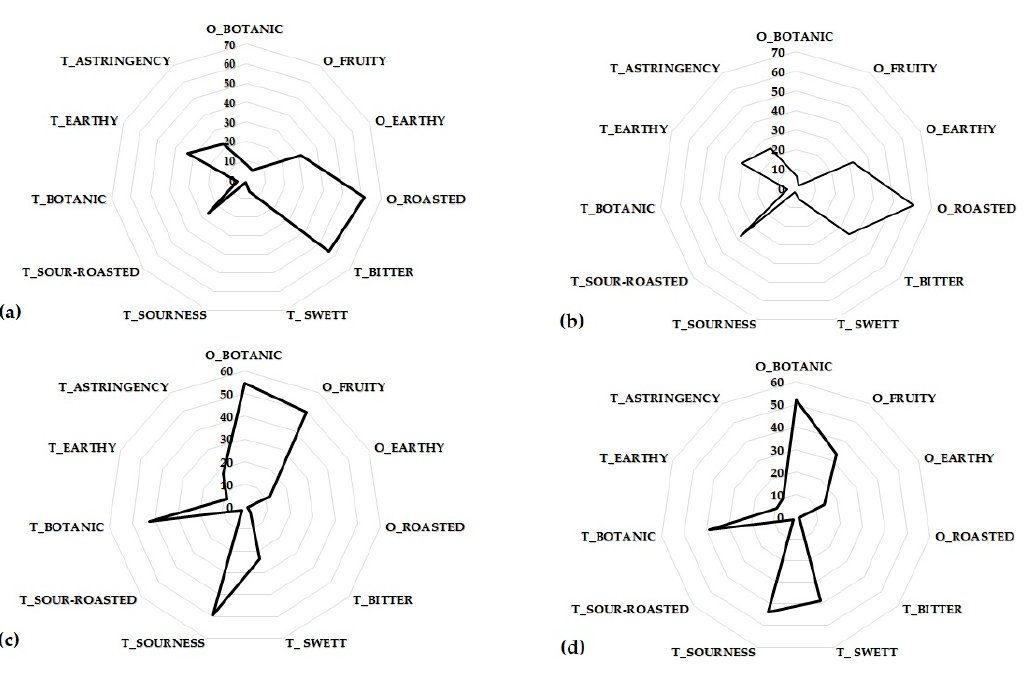
Figure 2. Spider graph for the sensory attributes of the di ff erent brews. ( a ) AQC: aqueous extract from co ff ee seeds, ( b ) AQC / CD: β -cyclodextrin extract from co ff ee seeds, ( c ) AQCW: aqueous extract from co ff ee pulp, ( d ) AQCW / CD: β -cyclodextrin extract from co ff ee pulp.